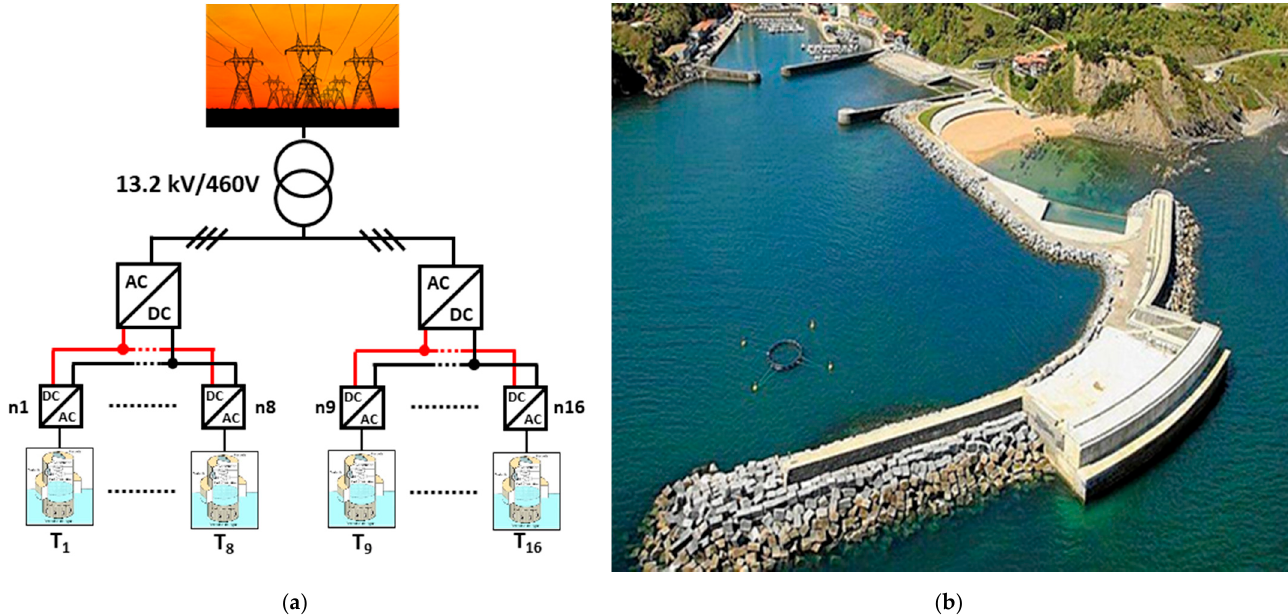
Figure 1. ( a ) Electrical diagram of the wave power generation plant and ( b ) aerial photo of the wave power generation plant integrated in the breakwater of Mutriku port.